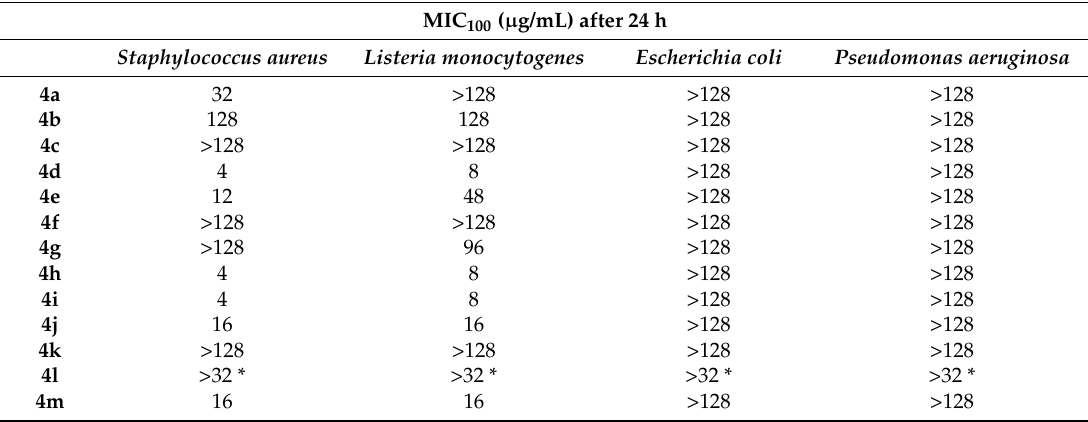
Table 2. Antimicrobial activity of 4a – m analogues, expressed as MIC 100 ( µ g/mL). MIC 100 ( µ g/mL) after 24